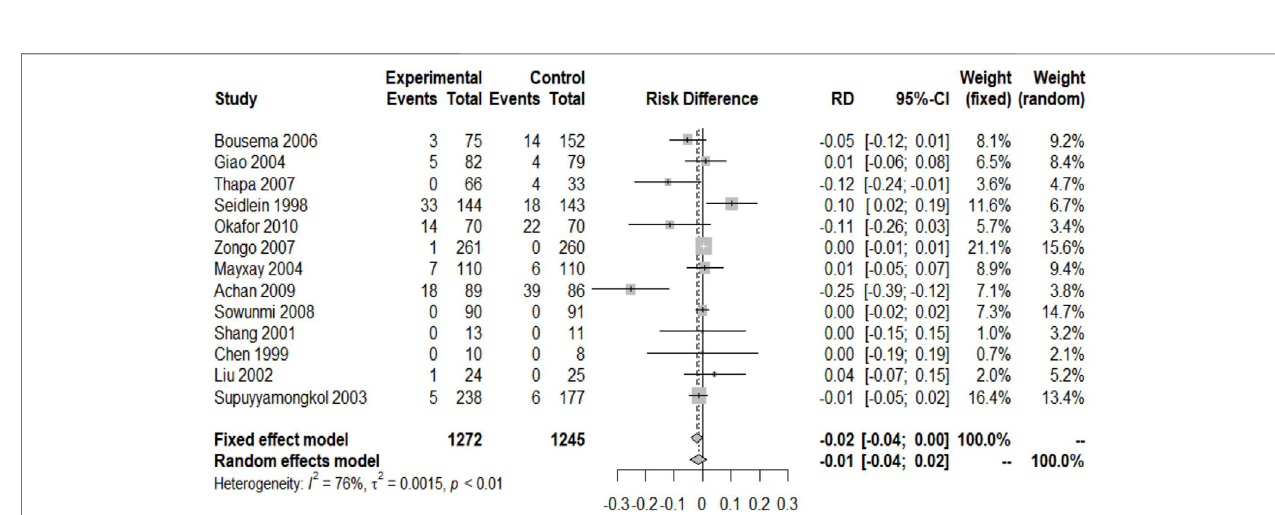
FIGURE 3 | Clinical treatment failure rate.